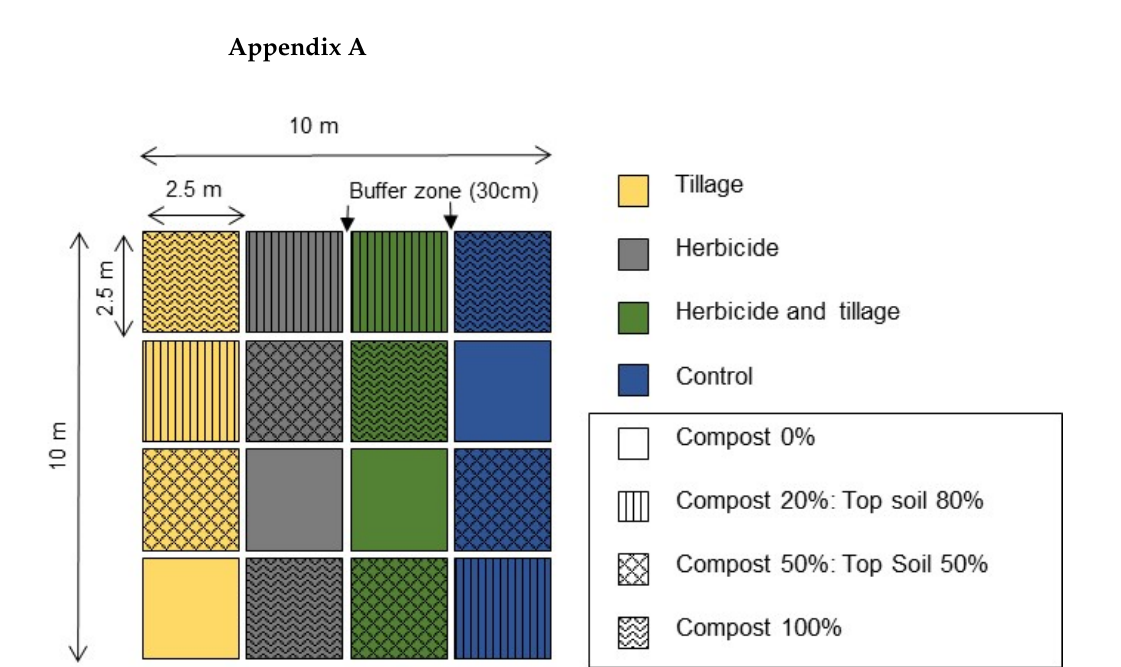
Figure A1. Plot design and soil preparation treatments (colored boxes) randomly applied in columns. Amendment treatments (patterns) randomly distributed within columns.